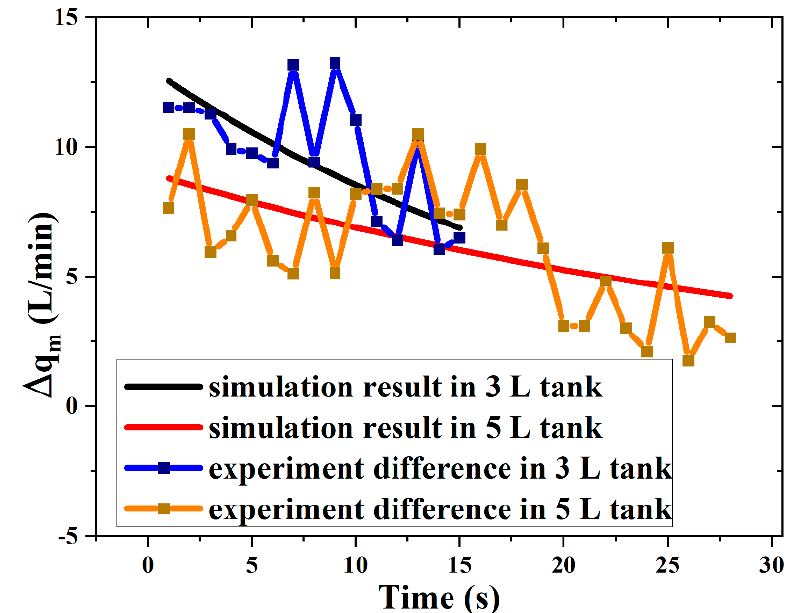
Figure 10. Comparison of experimental flow and calculated flow.